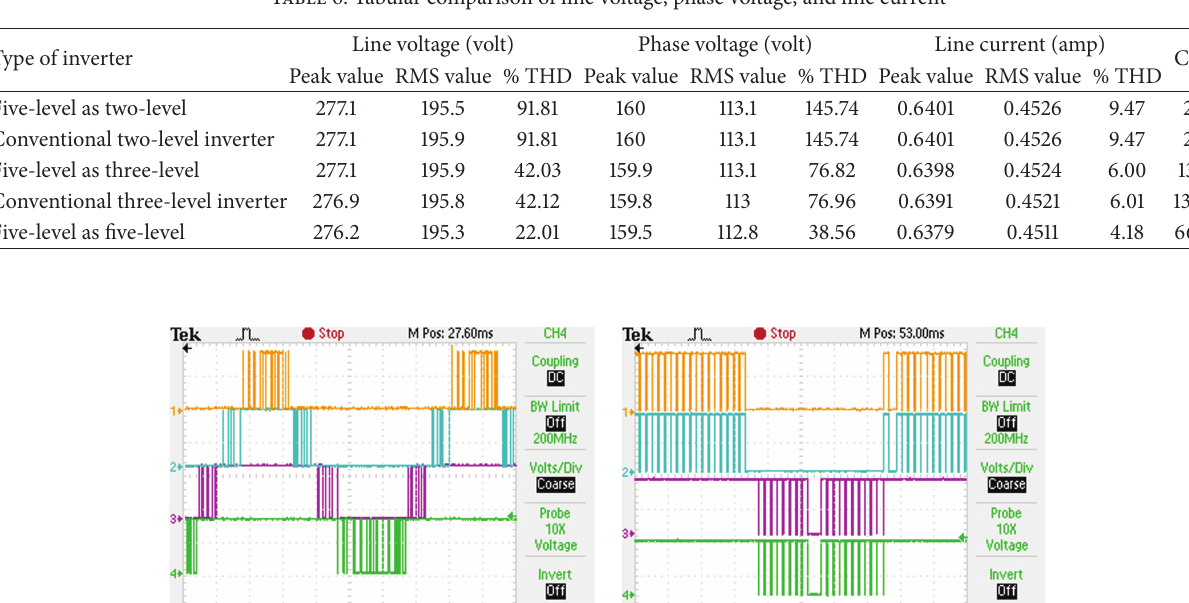
Table 6: Tabular comparison of line voltage, phase voltage, and line current